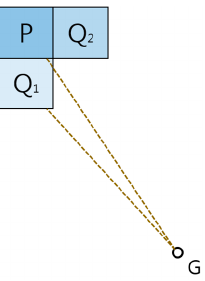
Figure 7. The case that robot is stopped in another position P, not same with position G.